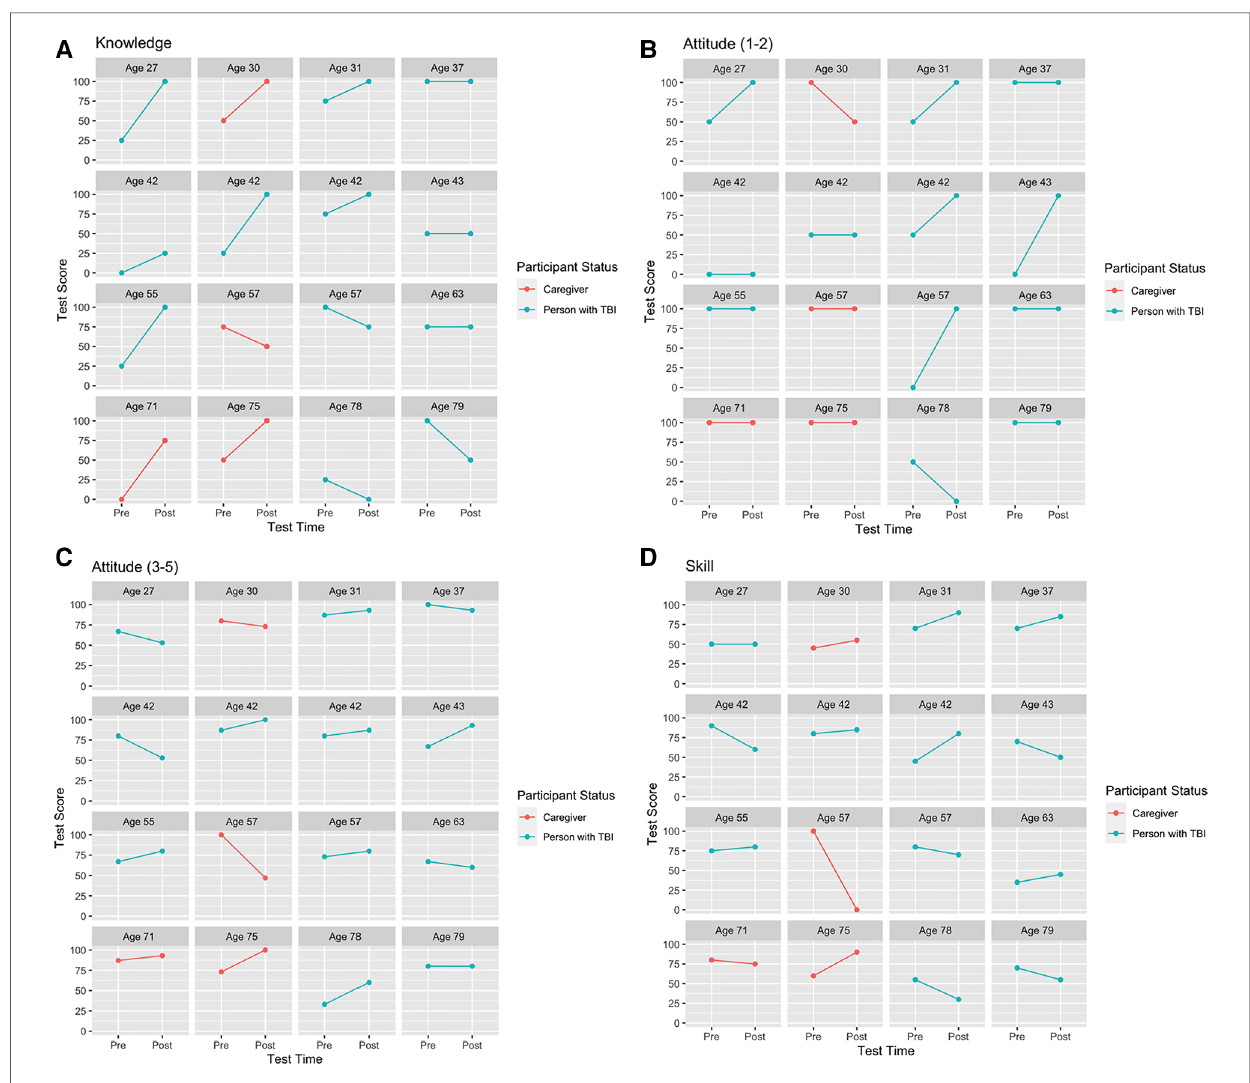
FIGURE 2 ( A – D ) by age. Learning pre- and post-test score. Plots of each person for ( A ) knowledge, ( B ) attitude (multiple-choice questions 1 – 2), ( C ) attitude (Likert- scale questions 3 – 5), and ( D ) skill showing improvement (positive slopes), no change (horizontal lines), or deterioration (negative slopes). All test scores are in percentage values. A post-test score of zero represents all responses were incorrect; questions were unanswered; or a combination of incorrect responses and unanswered questions for a particular